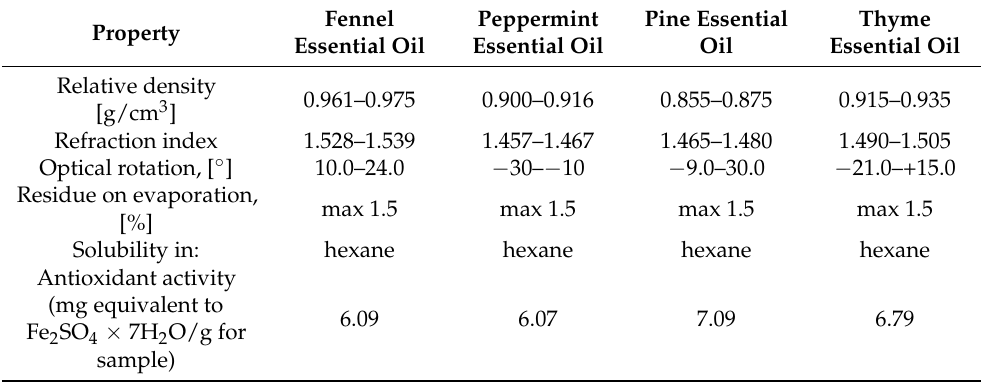
Table 2. Physical-chemical properties of fennel, peppermint, pine, and thyme essential oils.